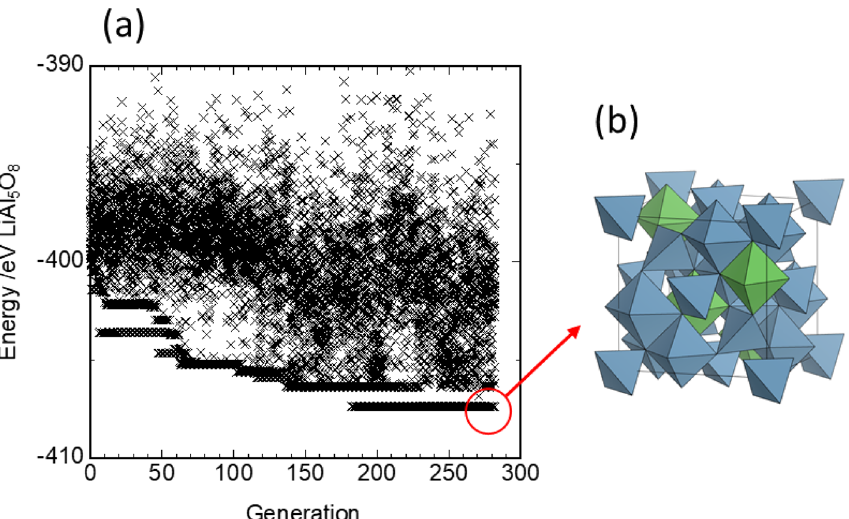
Figure 2. Determination of the most stable Li/Al/vacancy arrays of defect-free LiAl 5 O 8 (Model 1) using a genetic algorithm (GA). ( a ) Total electronic energy of GA-generated individual structures as a function of generation for spinel-type LiAl 5 O 8 . One generation consists of 20 individuals. ( b ) Most stable structure among GA-generated structure candidates. The centers of the blue and green polyhedra are occupied by Al and Li ions,